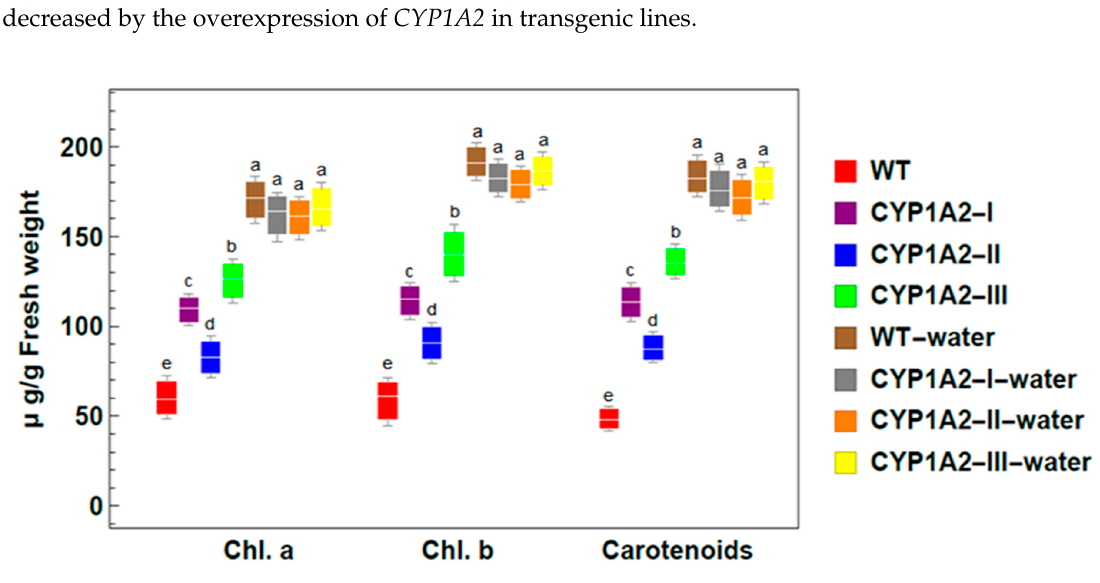
Figure 5. Photosynthetic pigment contents of wild type (WT) and CYP1A2 transgenic A. thaliana plants with and without isoproturon application. Photosynthetic pigments; Chlorophyll a (Chl. a), chlorophyll b (Chl. b), and carotenoid contents. WT: wild type; CYP1A2 -I, CYP1A2 -II, and CYP1A2 -III: A. thaliana plants transgenic for the CYP1A2 gene. Different lowercase letters indicate significant differences between the photosynthetic pigment contents for wild type and different lines of transgenic A. thaliana plants ( p < 0.05).